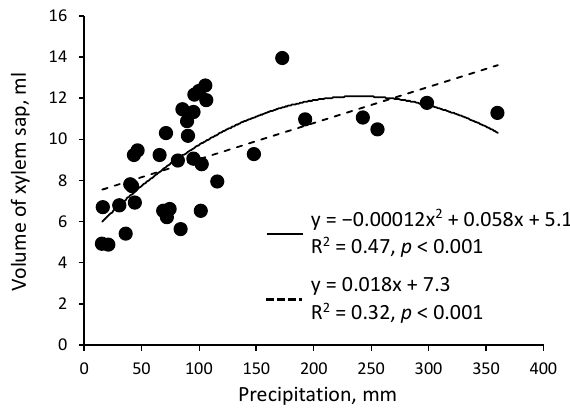
Figure 4. Relationship between the monthly volume of xylem sap collected in Q. serrata and the monthly precipitation. The presented data were from Experiments 1–3.